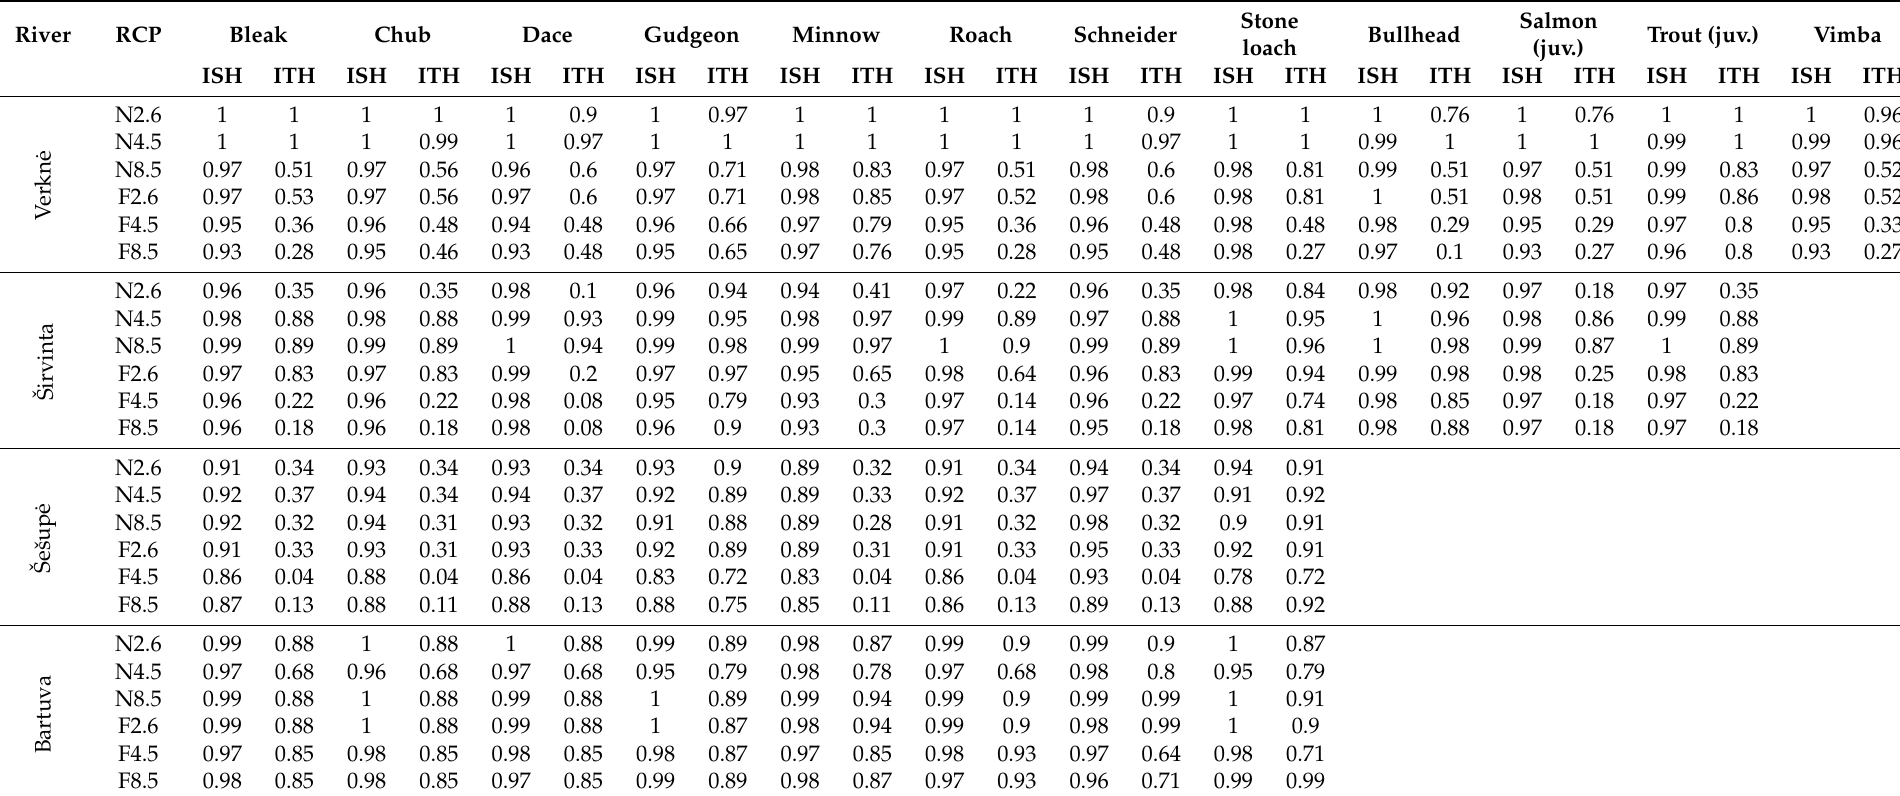
Table 6. ISH and ITH values for fish species at different RCP scenarios for the periods of 2021–2040 (N) and 2081–2100